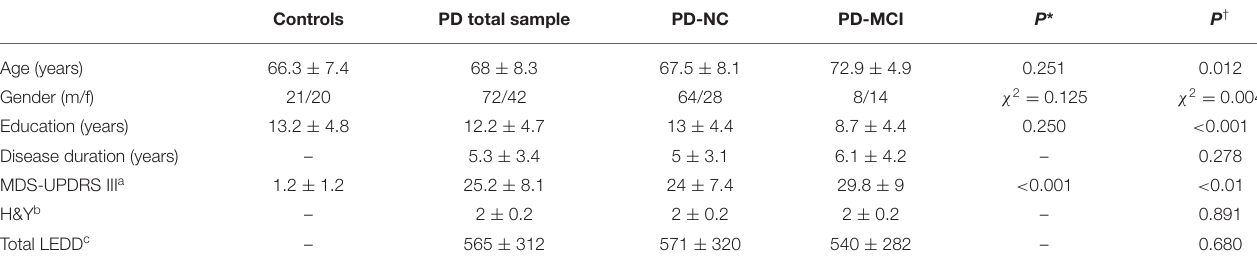
TABLE 1 | Clinic and sociodemographic characteristics of the sample.